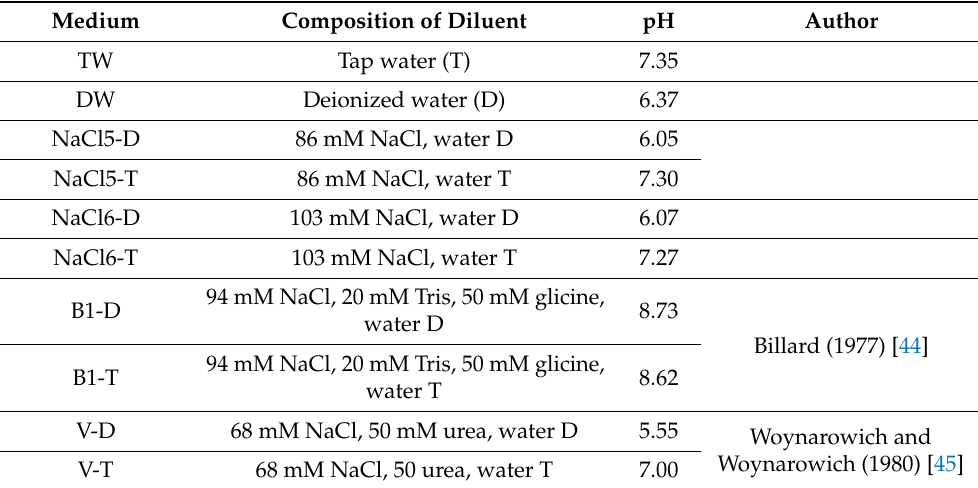
Table 1. The composition and pH of different activating media used in Experiment No. 1 for northern pike ( Esox lucius ) gametes. pH was measured during these studies. The “Author” column presents the authors of the work, the year of publication, and the reference number.